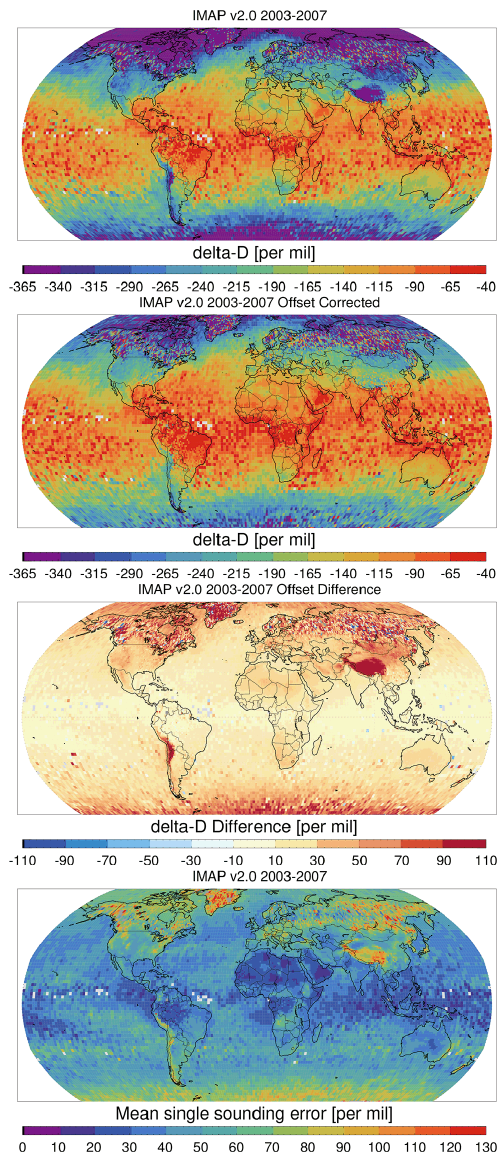
Figure 1. First: map of the new IMAP v2.0 2003–2007 δD data set. The resolution is 1 × 1 ◦ over land and 2 × 2 ◦ over water (non- weighted average of at least two retrievals per grid cell). Second: the same map after the offset correction. Third: difference between the map with and without the offset correction for the years 2003–2007. Fourth: mean single sounding